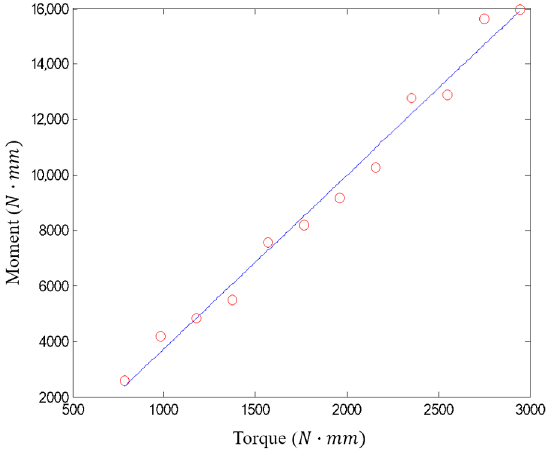
Figure 23. The rotational moment of the friction surface with the tightening force of the bolt.